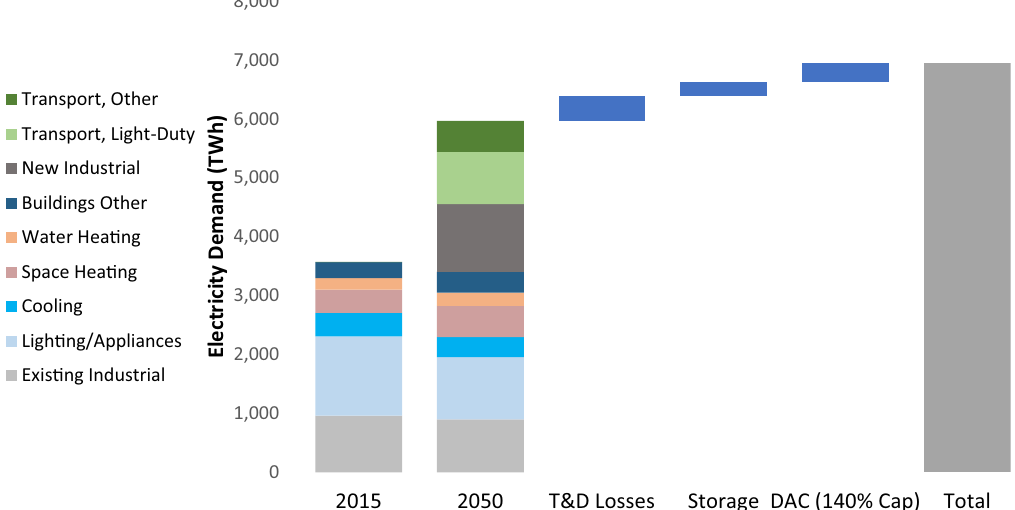
Fig. 7 Electricity demand decomposition by end-use application and supply losses. 2015 load is compared with simulated 2050 demand in the 140% electric sector CO 2 cap scenario with DAC only. Storage losses include net losses from all energy storage technologies (batteries, pumped hydro, and hydrogen via electrolysis). Electricity demand comes from the REGEN end-use model with assumptions described in the “ Methods ” section. Source data are provided as a Source Data fi le.